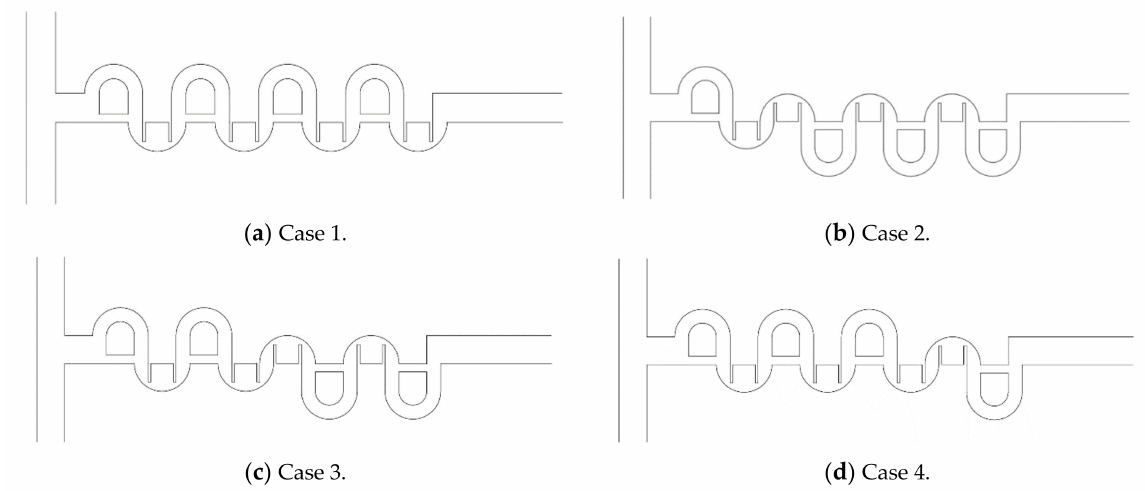
Figure 16. Schematic diagram of four micromixers combined with four CC-SARs and four